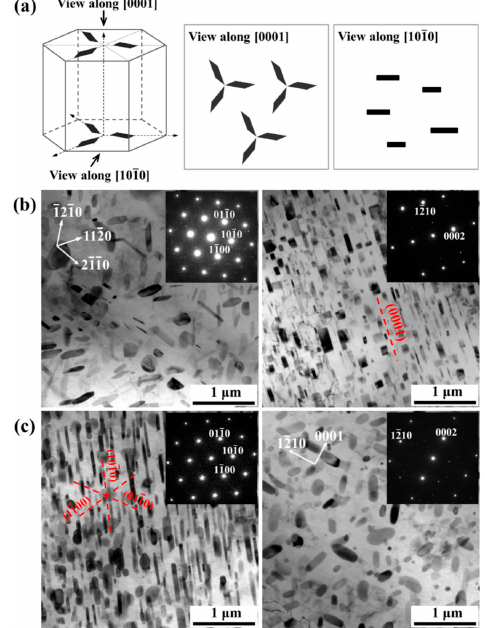
Figure 8. ( a ) Diagrams illustrating the morphologic characteristics of Mg 17 Al 12 precipitates